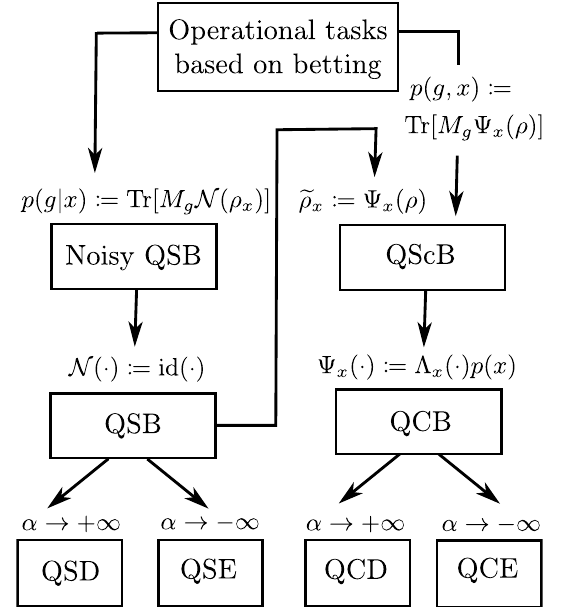
FIG. 2. Operational tasks based on betting and risk aversion. Quantum state betting, quantum-subchannel betting, quantum- channel betting, quantum state discrimination and exclusion, quantum-channel discrimination and exclusion. A → B means that the task A is more general than B